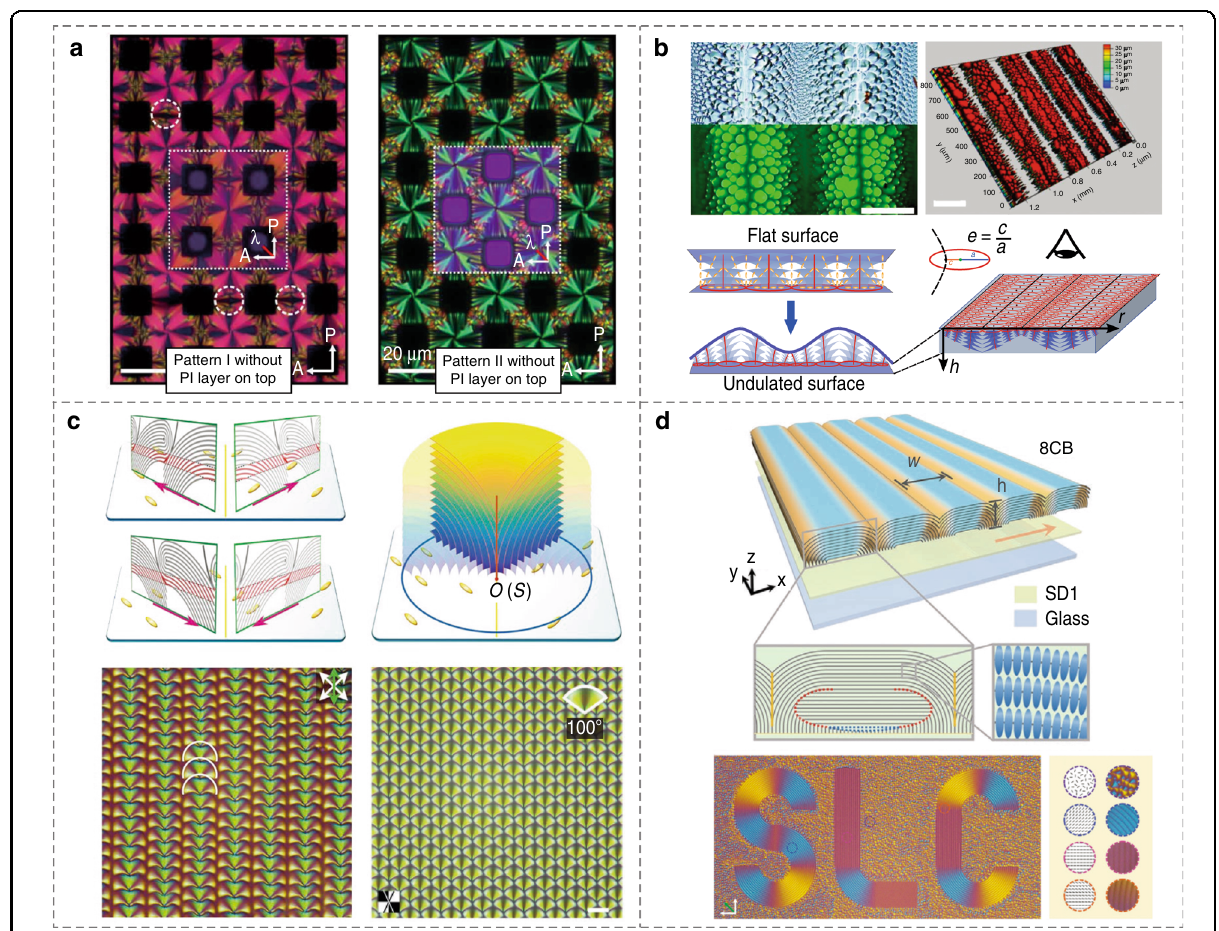
Fig. 4 Tailoring of smectic topological defects by geometric con fi nement and photoalignment. a Topographically patterned kaleidoscopic textures 65 . Reproduced from ref. 65 , with permission from AAAS. b Hierarchical assembly of FCDs by undulated surfaces 100 . Reproduced from ref. 100 , with permission from Royal Society of Chemistry. c Photopatterned topological FCDs 95 . Reproduced from ref. 95 , with permission from Wiley-VCH. d Photopatterned oily streaks 101 . Reproduced from ref. 101 , with permission from